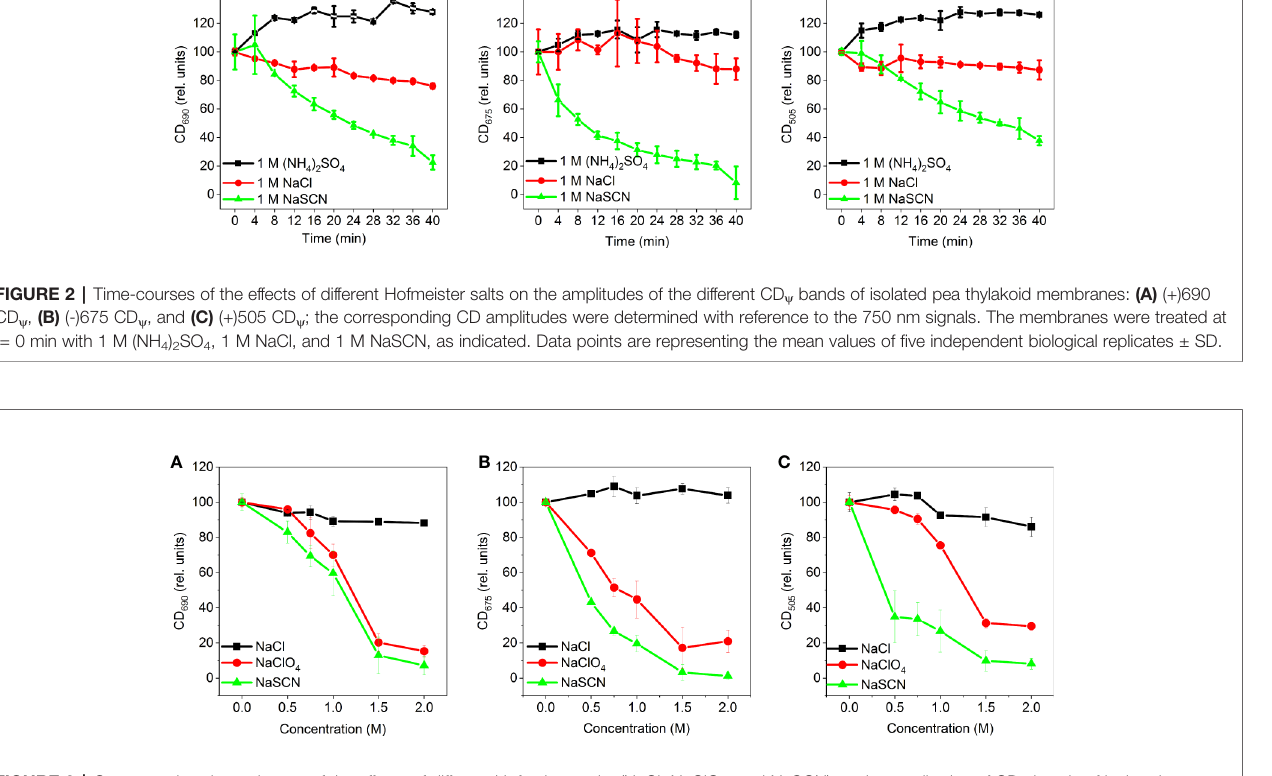
FIGURE 3 | Concentration dependences of the effects of different Hofmeister salts (NaCl, NaClO 4 , and NaSCN) on the amplitudes of CD y bands of isolated pea thylakoid membranes: (A) (+)690 CD y , (B) (-)675 CD y and (C) (+)505 CD y ; the amplitudes, relative to the control, were determined 20 min after the treatment, with reference to the corresponding 750 nm signal. Data points are representing the mean of three independent biological replicates ± SD.